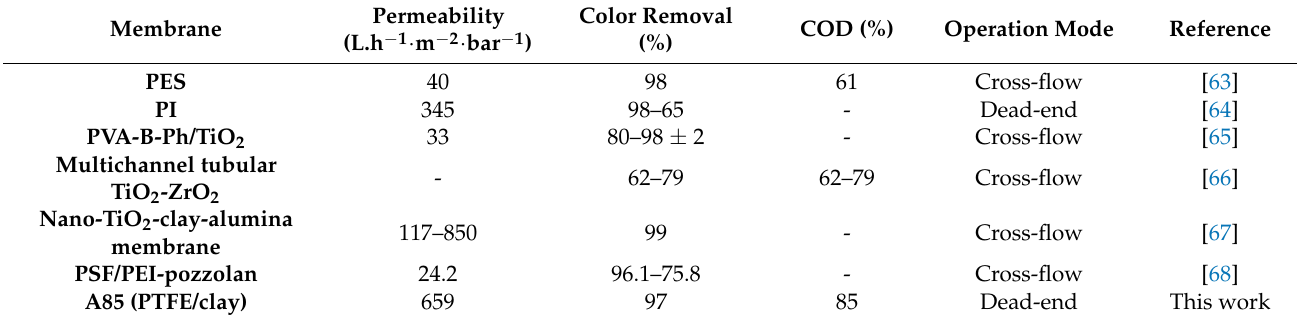
Table 7. Comparison of the performance between the PTFE/clay UF membrane and some reported membranes.